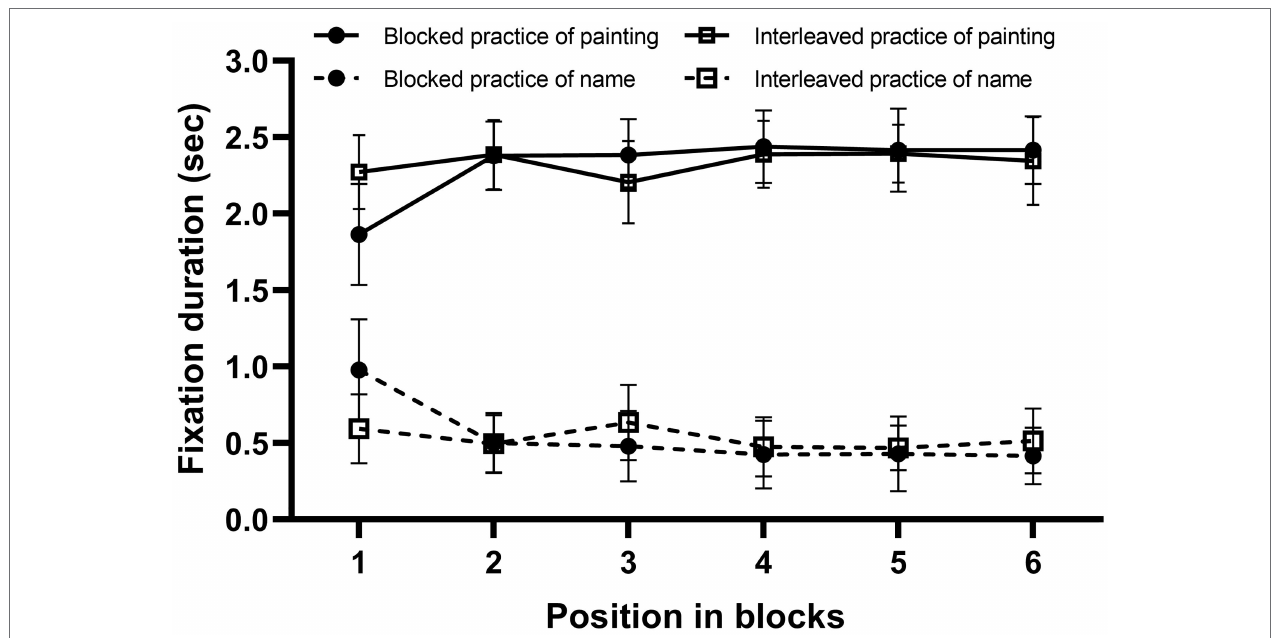
FIGURE 3 | Mean fixation durations for the paintings as a function of relative position and study condition in Experiment 1. Error bars represent